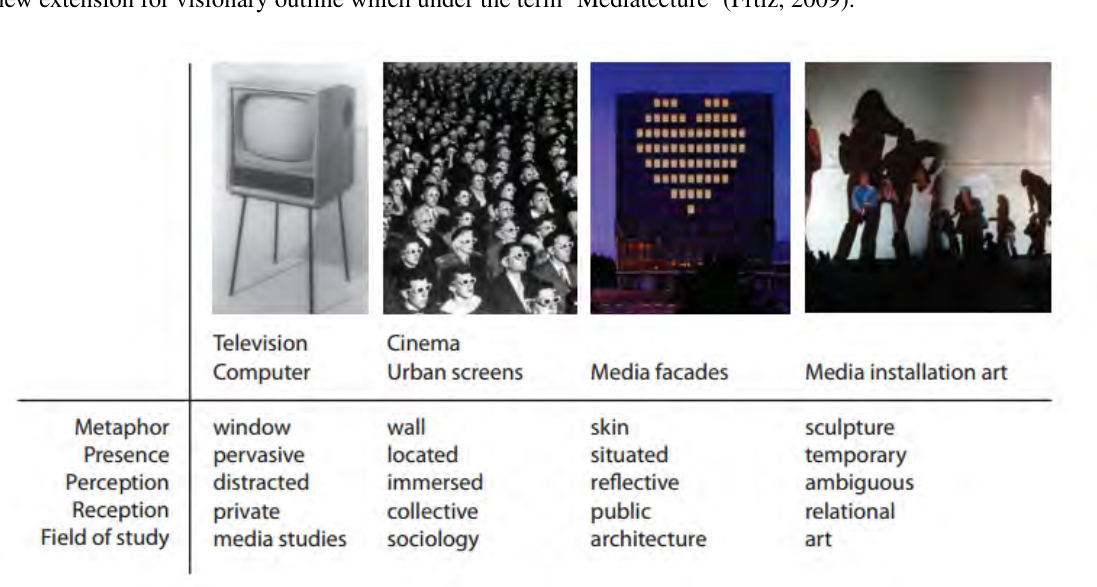
Figure 1. Physical evolution of the